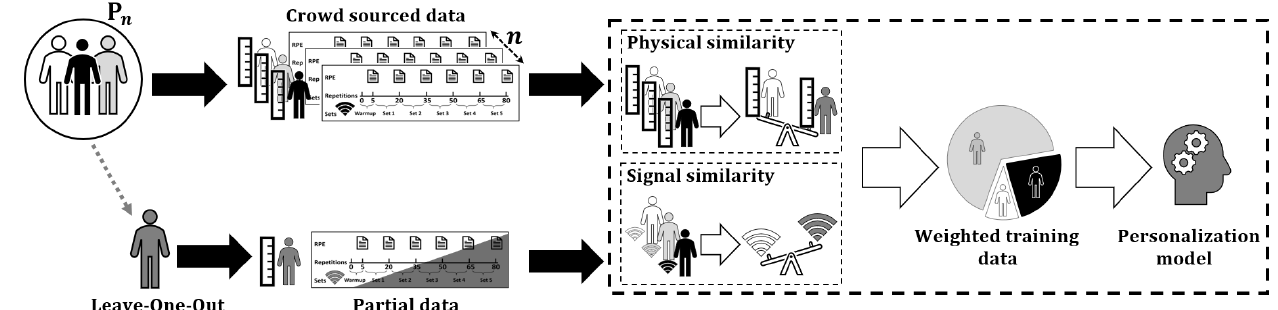
Figure 5. Visualization of the concept of personalizing general model using crowd-sourced wear- ables’ data.